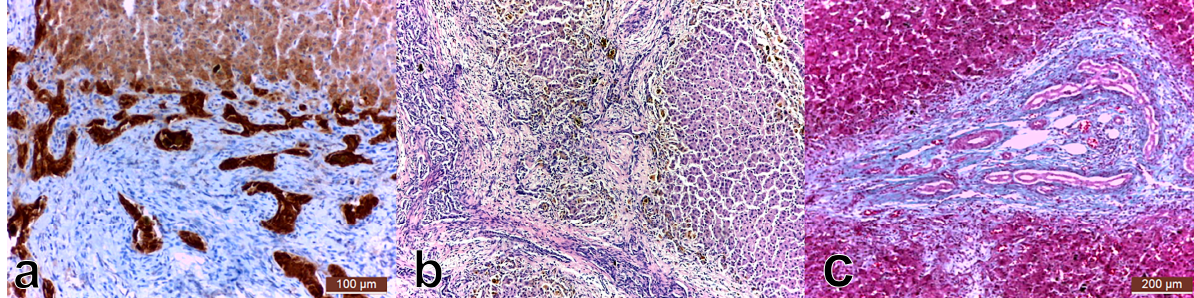
Figure 1. Hepatic biopsy: ( a ). Bile ductular proliferation (CK7 (cytokeratin), 20×, 100 µm); ( b ). Liver nodules with no centrolobular vein, with intracellular and canalicular cholestasis (HE (hematoxylin eosin), 100×); ( c ). Ductal plate malformation (TM (trichrome masson), 10×, 200 µm).